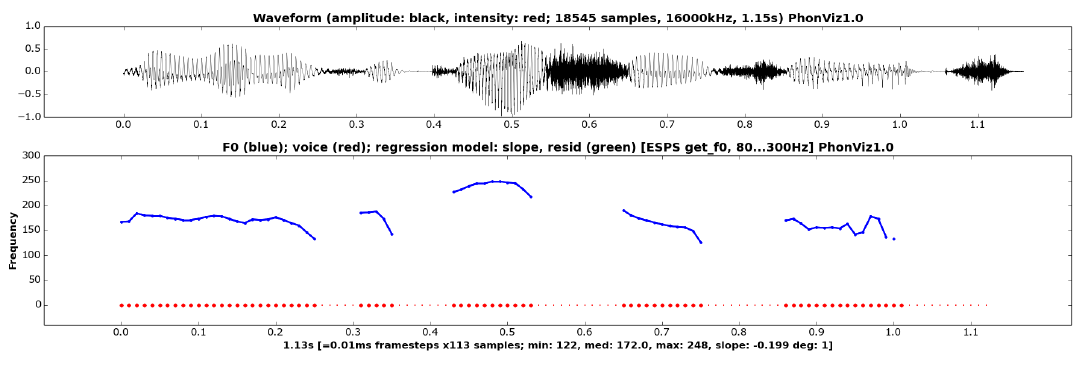
Figure 9: Waveform, pitch trace and voice traces for constituents of the nominal phrase “the Unification Church” (BBC news, female